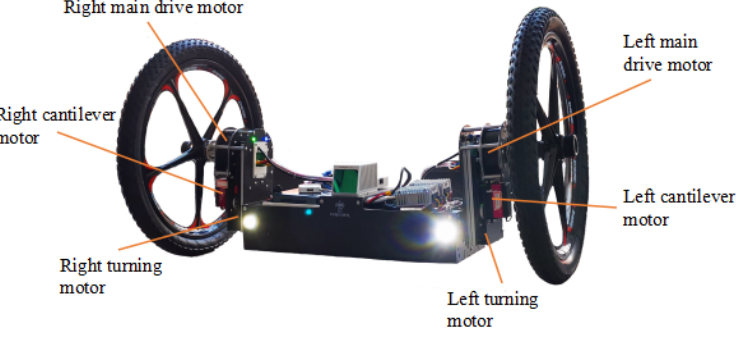
Figure 15. Prototype model. Table 2. Robot parameters and experimental performance.